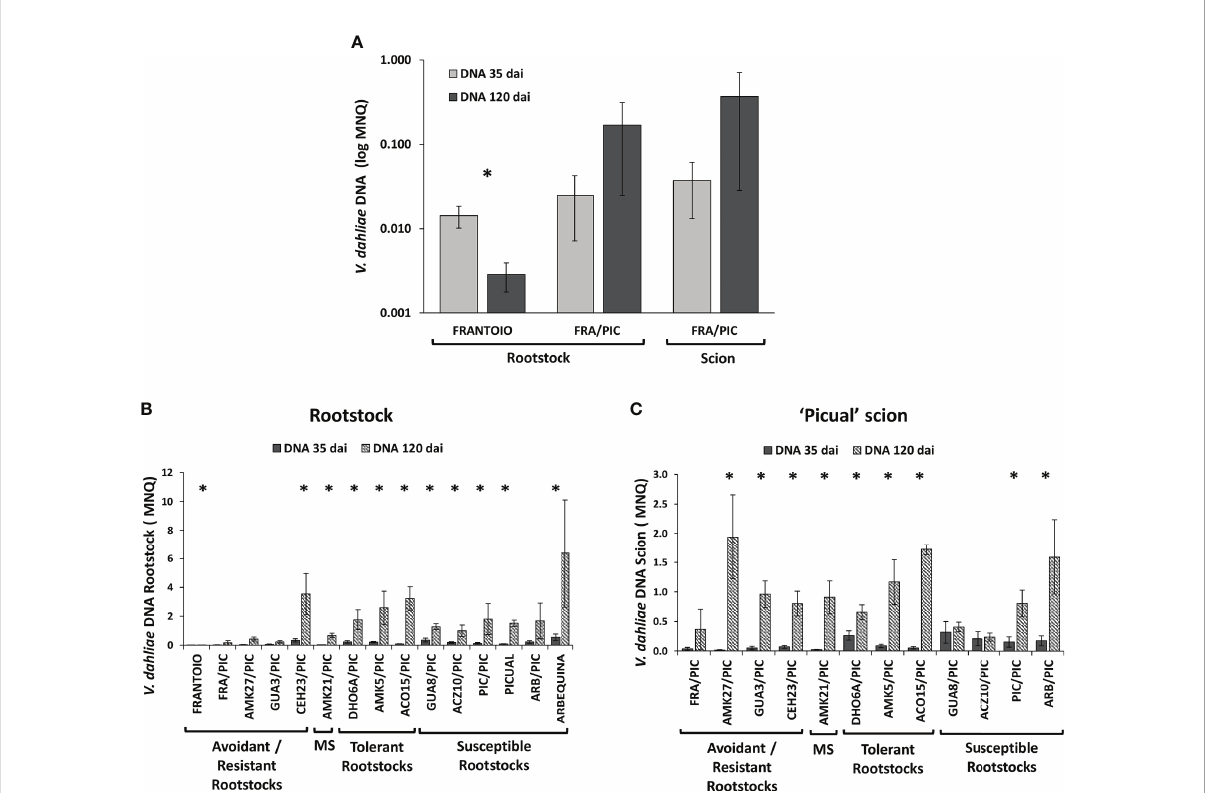
FIGURE 6 Mean Normalized Quantity (MNQ) of Verticillium dahliae DNA in the rootstock trunks of non-grafted ‘ Frantoio ’ and ‘ Frantoio ’ grafted with ‘ Picual ’ (FRA/PIC) and in the corresponding grafted ‘ Picual ’ scion (A) , and in the rootstock trunks (B) and ‘ Picual ’ scions (C) of wild olive genotypes grafted with ‘ Picual ’ at 35 and 120 days after inoculation (dai) with the V. dahliae defoliating isolate VD117. Asterisks indicate signi fi cant differences between 35 and 120 dai. Results are the mean of 8 plants at 35 dai and 16 plants at 120 dai, and error bars correspond to the standard